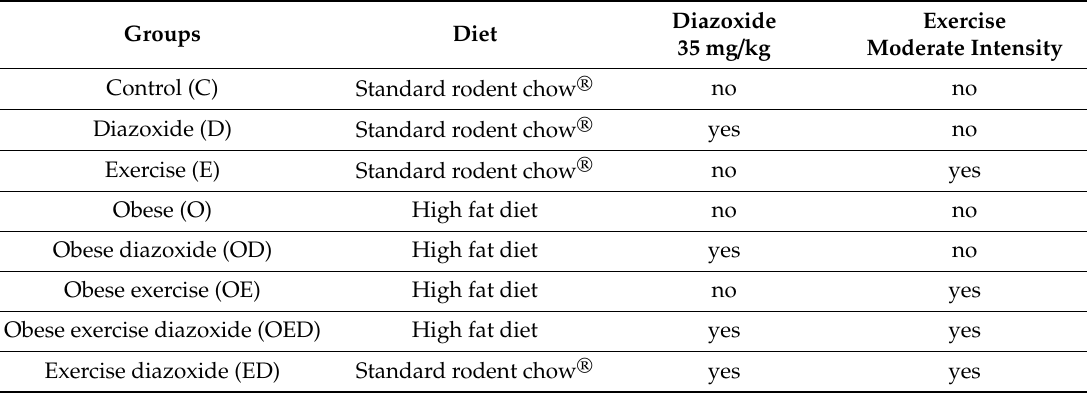
Table 1. Experimental